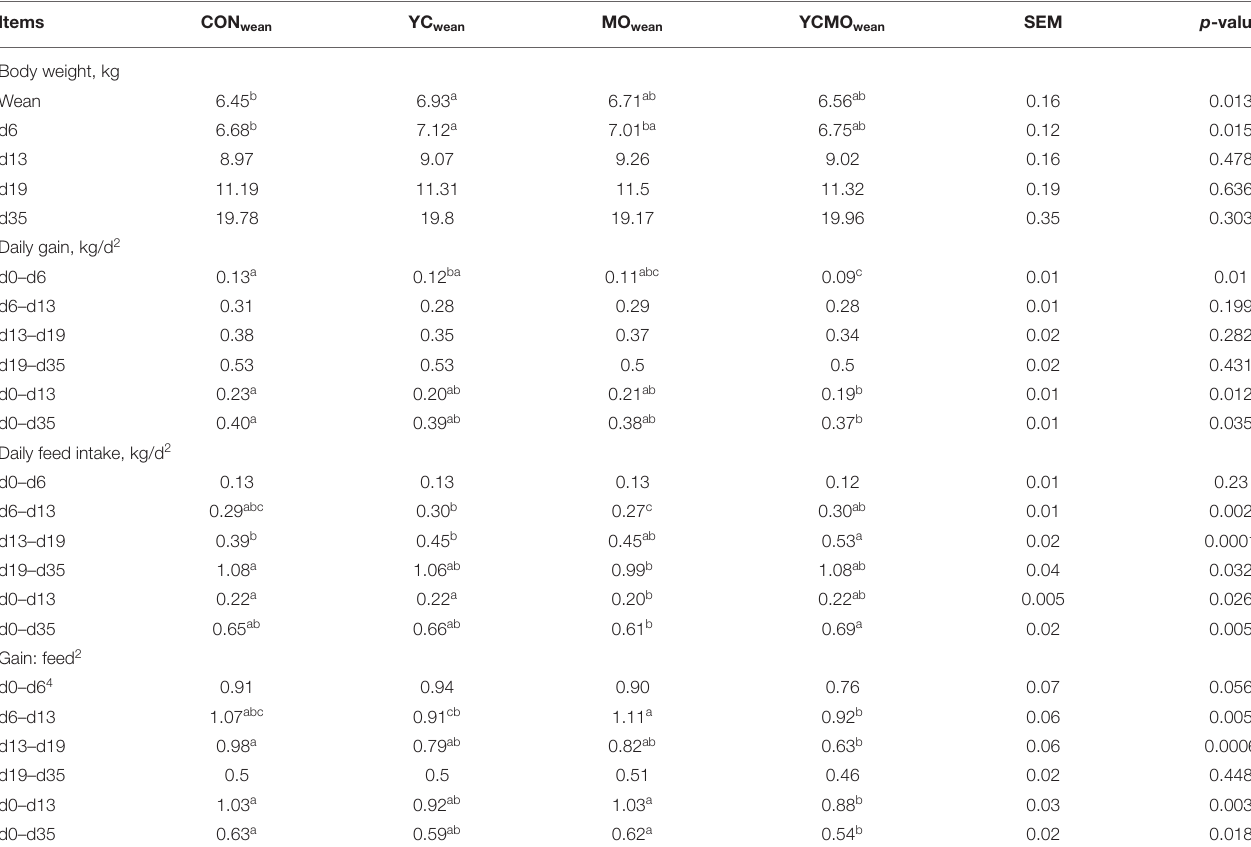
TABLE 4 | Performance of weaned pigs provided diets with or without a whole yeast cell component (YC) and with or without a peppermint oil (MO) blend over a four-phase feeding program (study 1) 1,3 . Items Body weight,